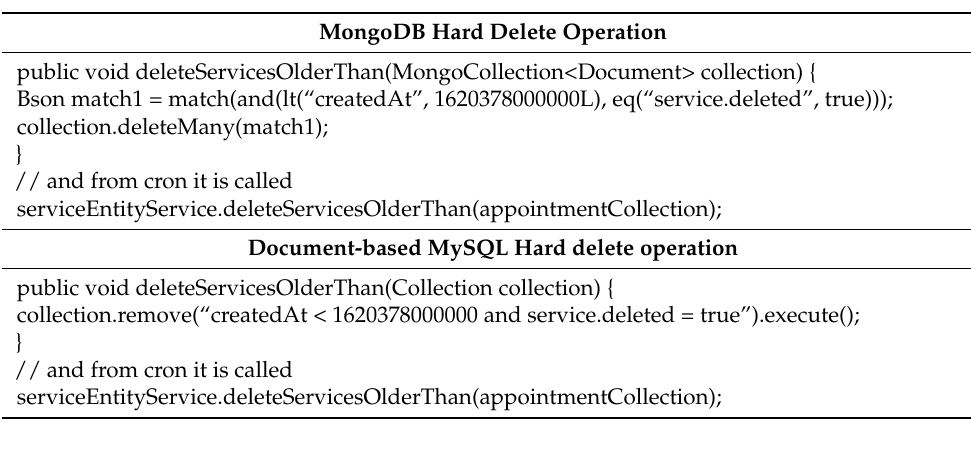
Table 10. Hard delete operation.